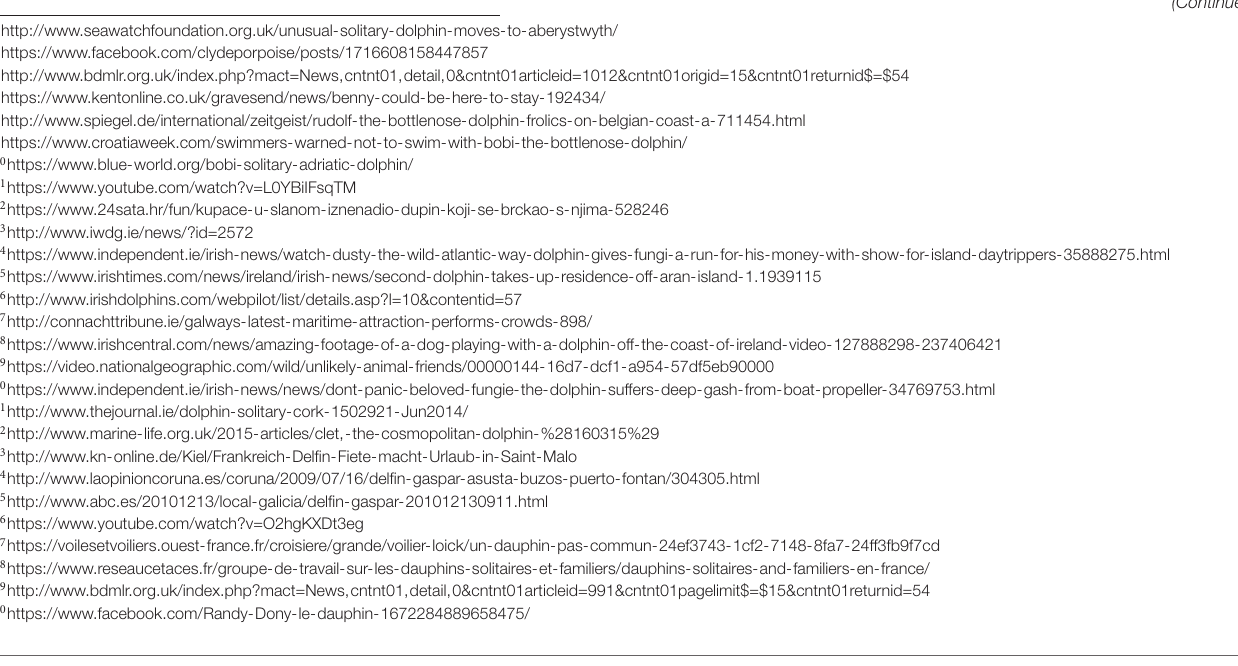
TABLE 2 | Solitary and solitary-sociable dolphins in Europe since 2008. Stage (Level)